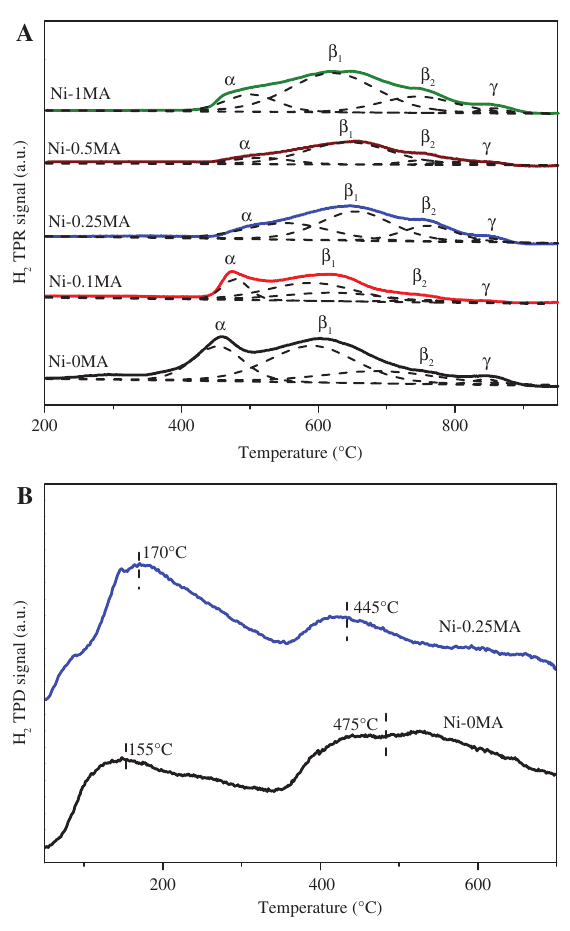
Figure 3: Profiles of the catalysts. (A) H -TPR profiles of the catalysts; (B) H 2